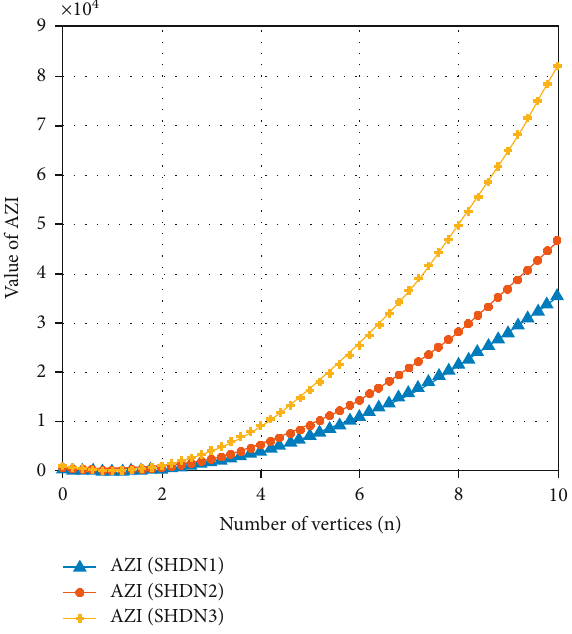
n Þ , Γ n Þ , and Γ 1 ð 2 ð